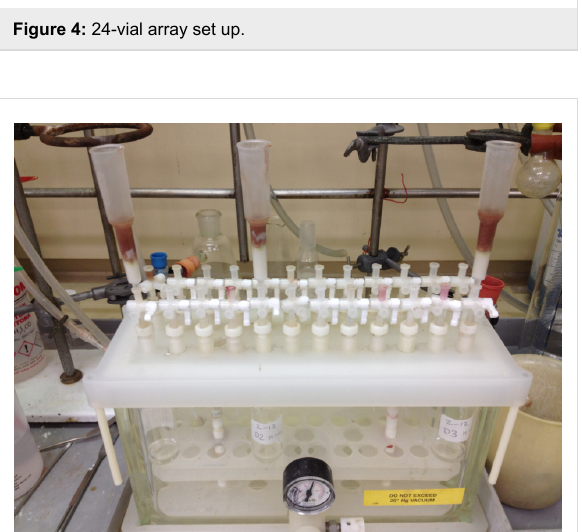
Figure 4: 24-vial array set up.